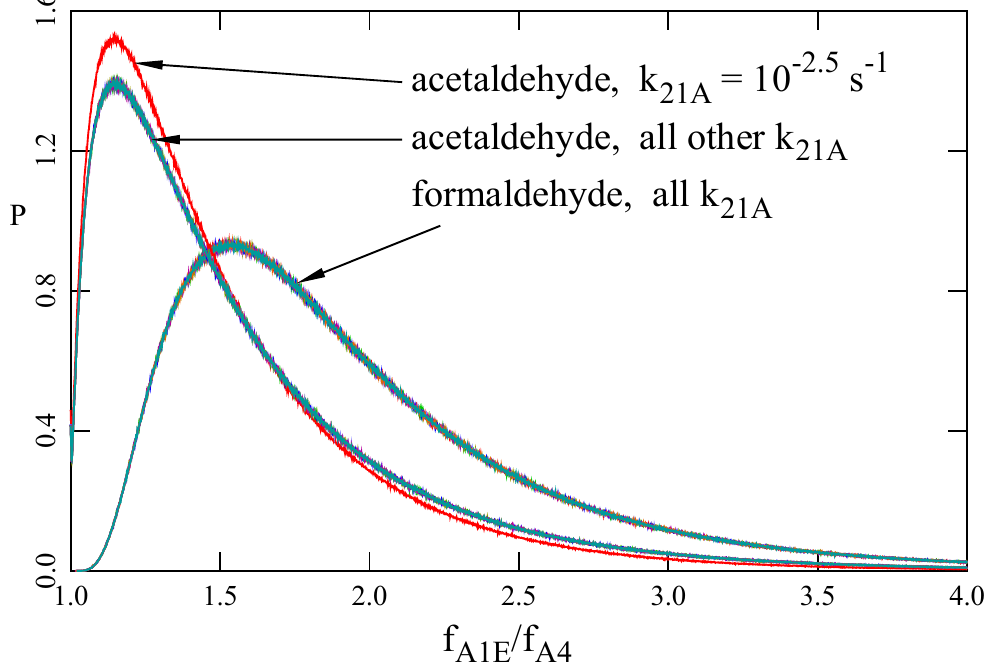
Figure 9. Distribution of the ratio f A1E / f A4 for the formaldehyde and acetaldehyde models. Curves for k 21A between 10 − 6 s − 1 and 10 − 2.5 s − 1 are all displayed, but except for acetaldehyde at k 21 A = 10 − 2.5 s − 1 , they are practically indistinguishable; 1.8% and 0.6% of the probability density, for formaldehyde and acetaldehyde respectively, are in the tails at f A1E / f A4 > 4.